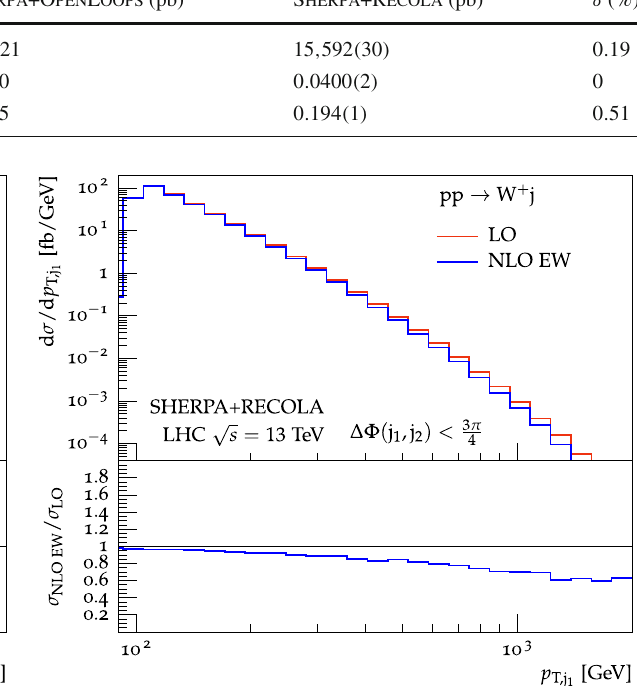
Fig. 7 Differential distributions at 13TeV for pp → W + j at the LHC, both at LO and NLO EW. The left-hand figure shows the leading-jet p T with minimal cuts and the right-hand plot the leading-jet p T with an